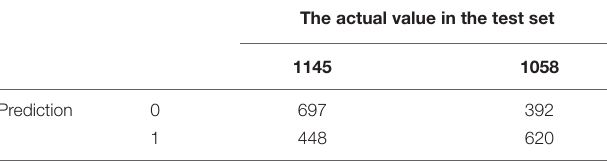
TABLE 6 | Confusion matrix of XG-boost.